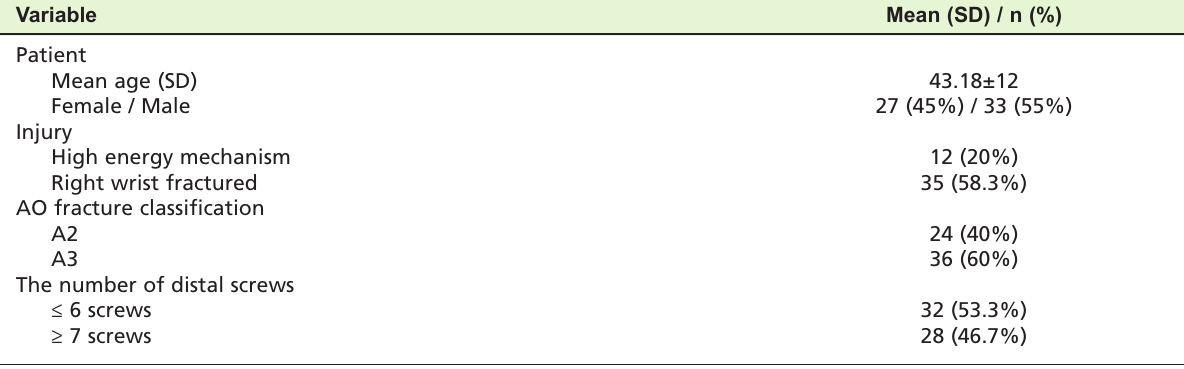
Table I: Descriptive characteristics of patients with distal radius fractures undergone volar locking plate fixation